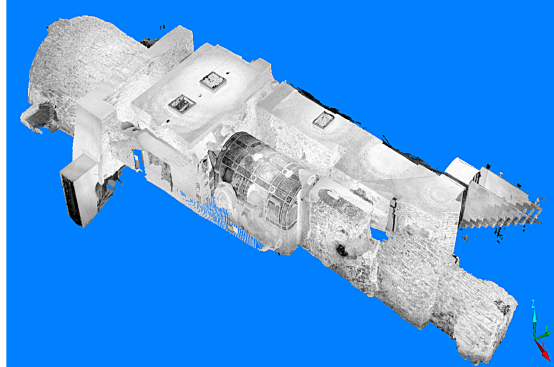
Figure 2. The hypogea system under the church. The scans we re registered together for a complete view of this particular spatial